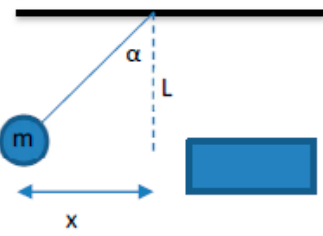
Figure 6. Micro-pendulum thrust stand.